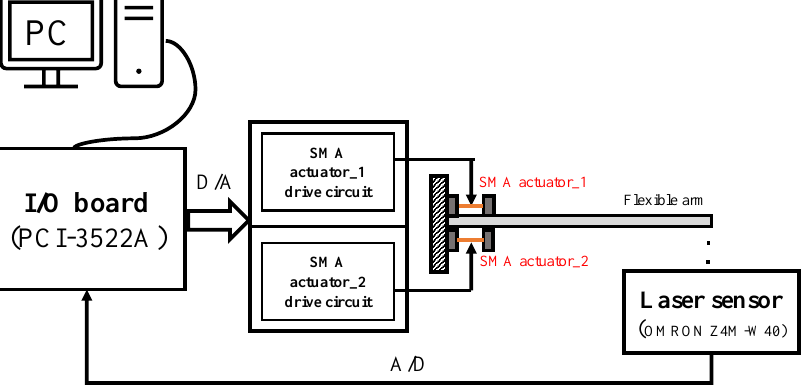
Figure 5. Schematic of the experimental setup.